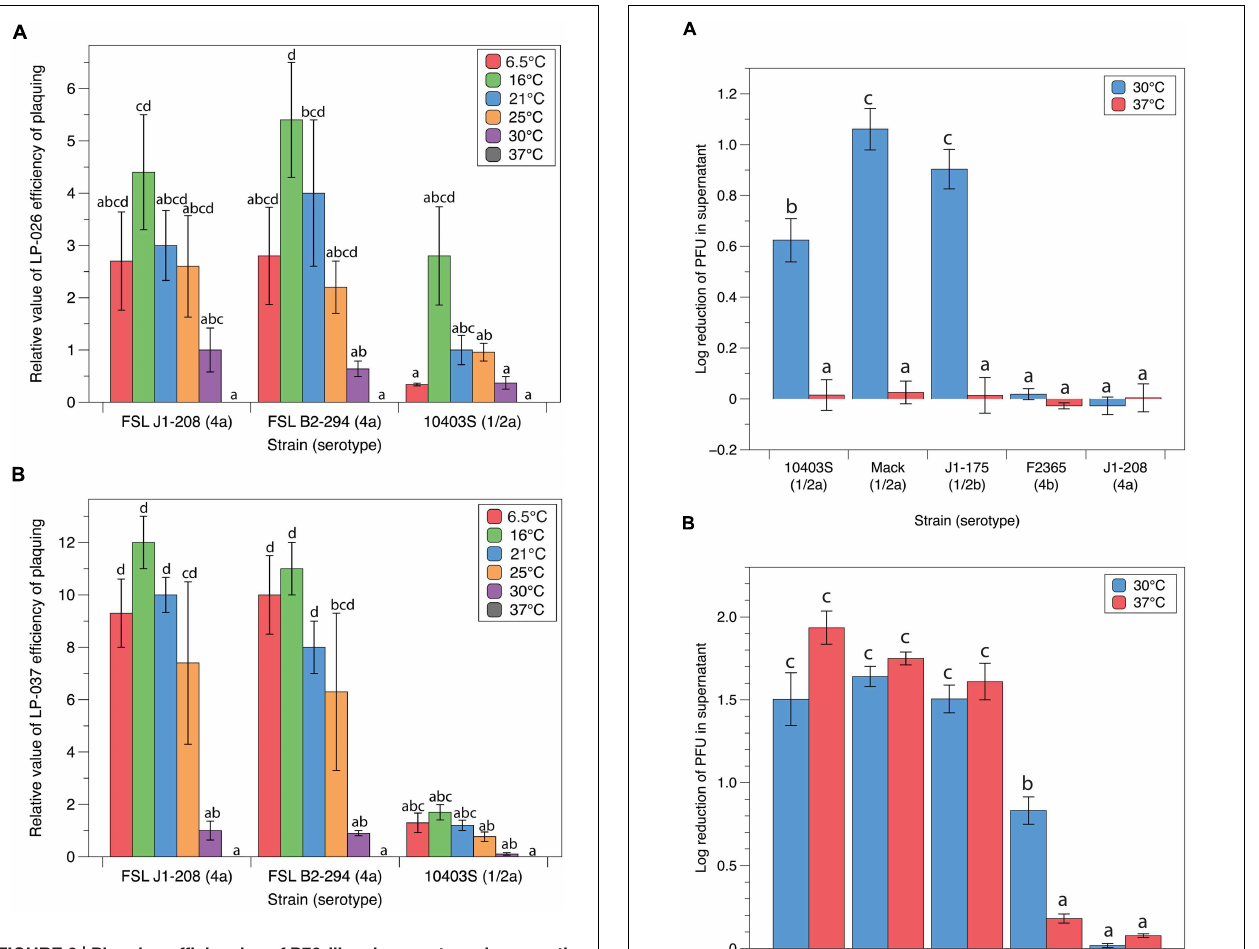
FIGURE 3 | Plaquing efficiencies of P70-like phages at varying growth temperatures. The relative number of visible plaques under different strain and temperature conditions were compared for phages (A) LP-026 and (B) LP-037. All values are relative to the phage’s isolation conditions (strain J1-208 at 30 ◦ C). Bars that do not share any letters represent values that are significantly different; for example, a bar marked with a, b, and c is significantly different from a bar marked with d. Three biological replicates were conducted. Error bars represent the standard error.